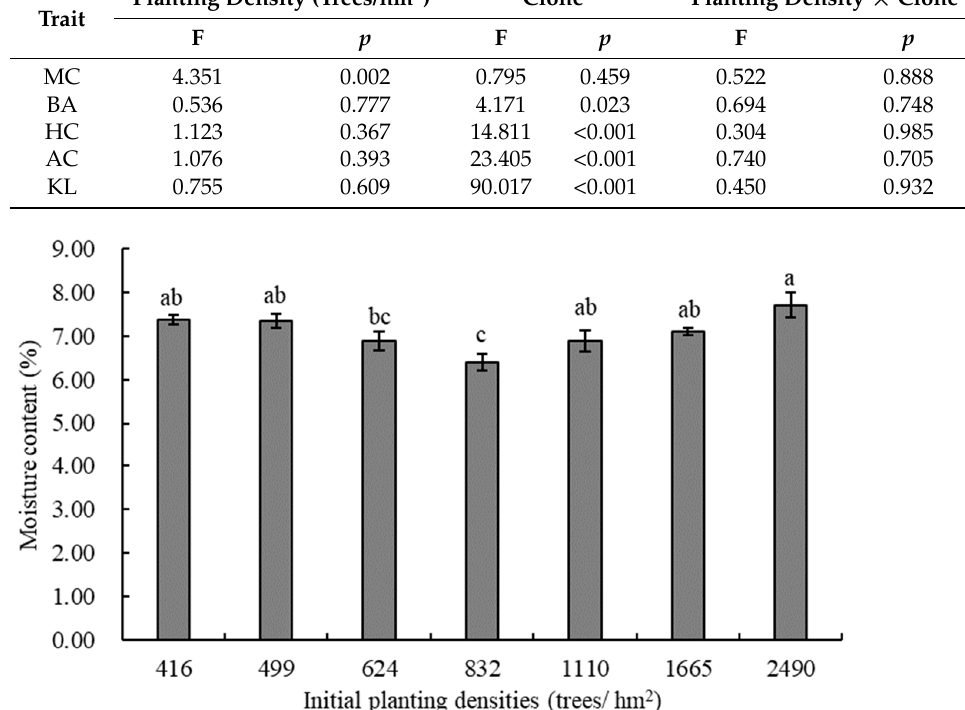
Figure 1. Effects of initial planting density on the moisture content of triploid Chinese white poplars. Different letters indicate a significant difference under different planting densities ( p < 0.05).